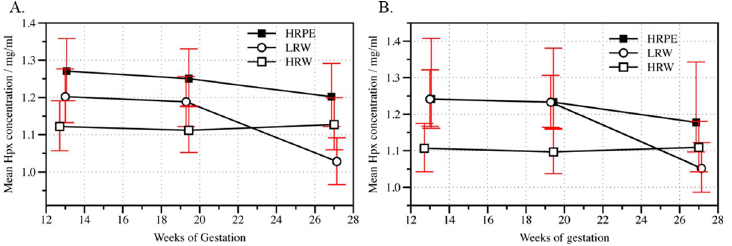
Fig 2. Geometric mean of plasma hemopexin concentration in three study groups by duration of gestation. The geometric means and the 95% confidence intervals (red bars) of the plasma hemopexin (Hpx) concentration among low-risk women (LRW) and high-risk women who did (HRPE) and did not (HRW) develop pre-eclampsia. Data shown by weeks of gestation (A) before and (B) after adjustment for body mass index.